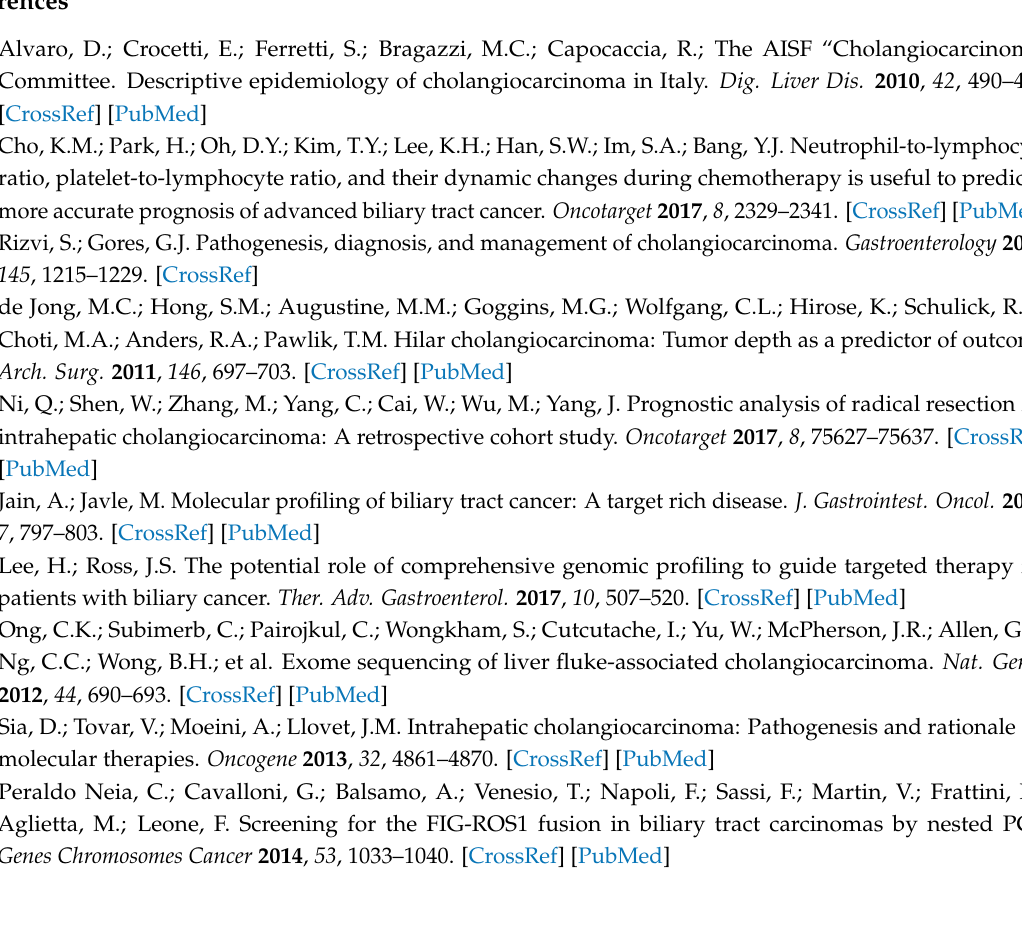
Figure S1: Ct values and amplification curves of qPCR of cfDNA obtained from 1 IDH1m patient analyzed at different time points. In blue the WT curves, in green the mutated ones, Figure S2: CT scan images at the baseline (A) and after 6 weeks (B). Scale bar represent 10 mm, Figure S3: CT scan images at 12 weeks (C) and 18 weeks (D) from baseline. Scale bar represent 10 mm, Figure S4: Sensitivity of nested PCR for the amplification of IDH1 exon 4, Table S1: Primers used for IDH1 mutational analysis. Probes and oligonucleotides for